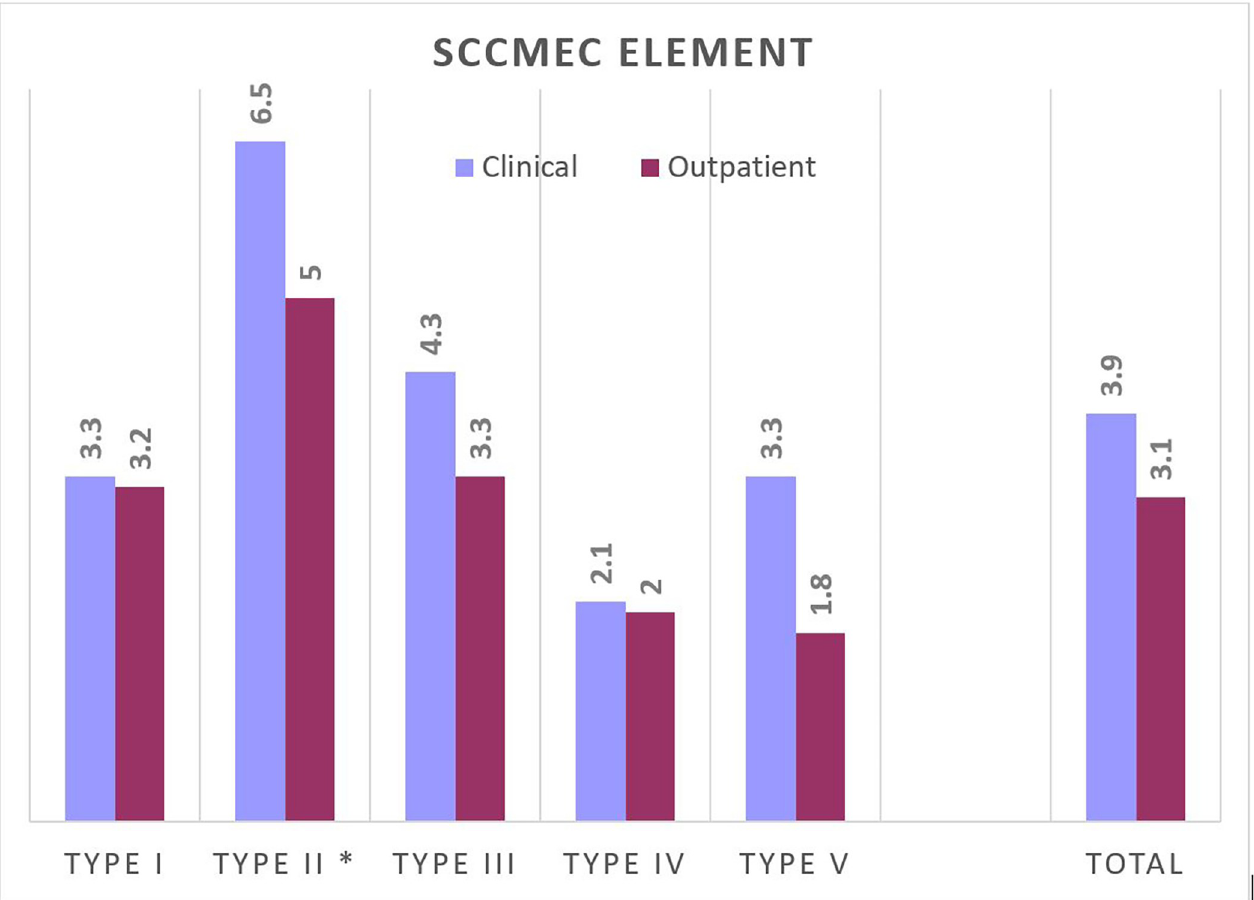
Fig 2. Average antimicrobial resistance of clinical and outpatients MRSA isolates with different SCC mec types. � A small number of isolates.